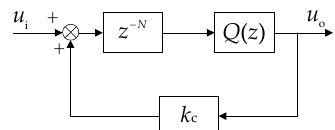
1 k  , the amplitude-frequency characteristic curves of RC under c